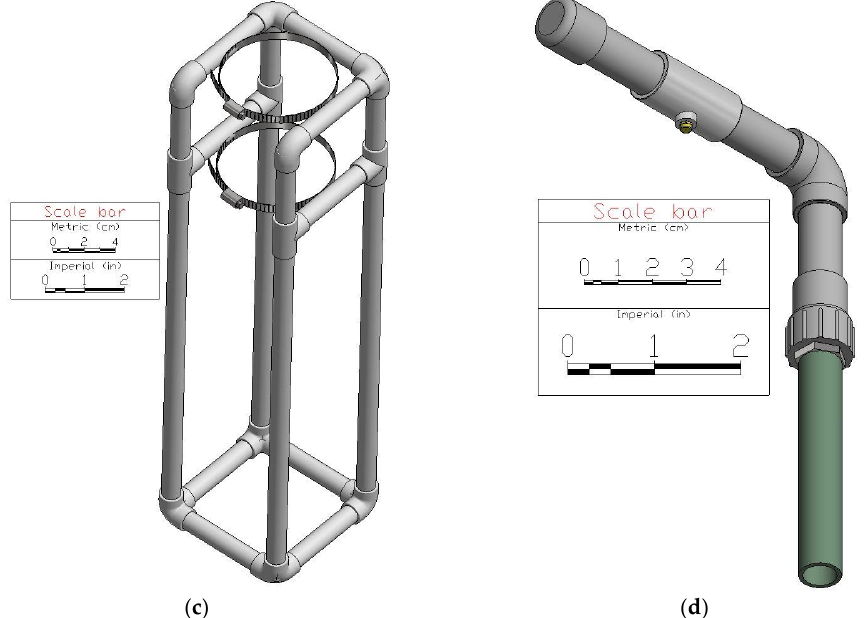
Figure 1. ( a ) The complete soil column system composed of three components: ( b ) the soil column, ( c ) the soil column stand, ( d ) the soil column mist nozzle and piping.